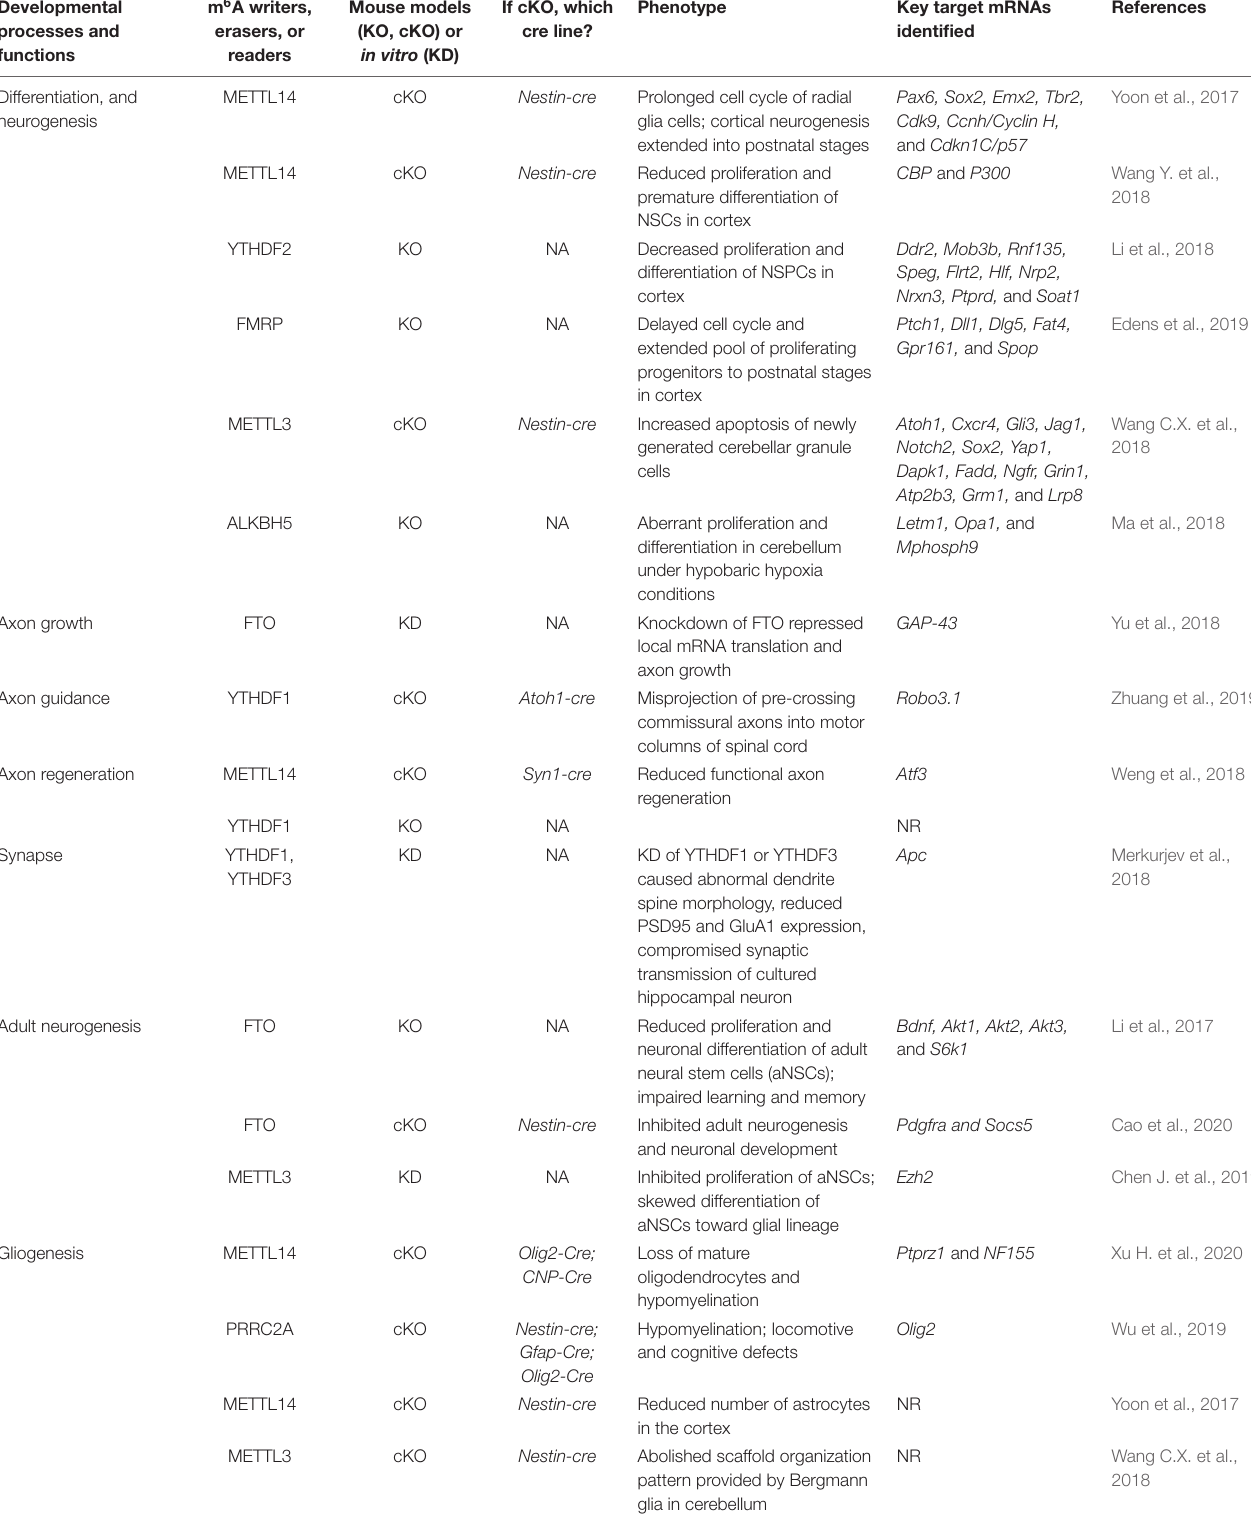
TABLE 1 | Roles of m 6 A modification in neuronal development and functions. Developmental processes